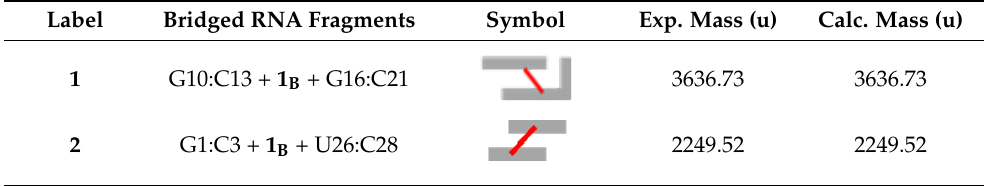
Figure 5. ( A ) Representative region of ESI-MS spectrum obtained after RNAse A digestion of TAR RNA (1 μM) reacted with 10 μ M of B-CeP 1 . Only the most relevant bridged alkylation products, which are cross-referenced in Table 2 and highlighted in the cartoon on panel B, are indicated in the spectrum. Oligonucleotides products are indicated by the first and last base separated by co- lon. Product labels indicate the bi-functional alkylation products bridging base-paired regions within the TAR RNA hairpin. ( B ). Cartoon of the B-CeP 1 -induced bi-functional alkylation prod- ucts bridging base-paired regions within the TAR RNA secondary structure. Table 2. Bi-functional alkylation products bridging base-paired regions within TAR RNA hairpin detected by treating TAR RNA with B-CeP 1 , followed by RNAse A digestion. Product labels refer to Figure 5. Oligonucleotides products are indicated by the first and last base, separated by colon. Product labels are also reported on the hairpin secondary structure cartoon in Figure 5B.